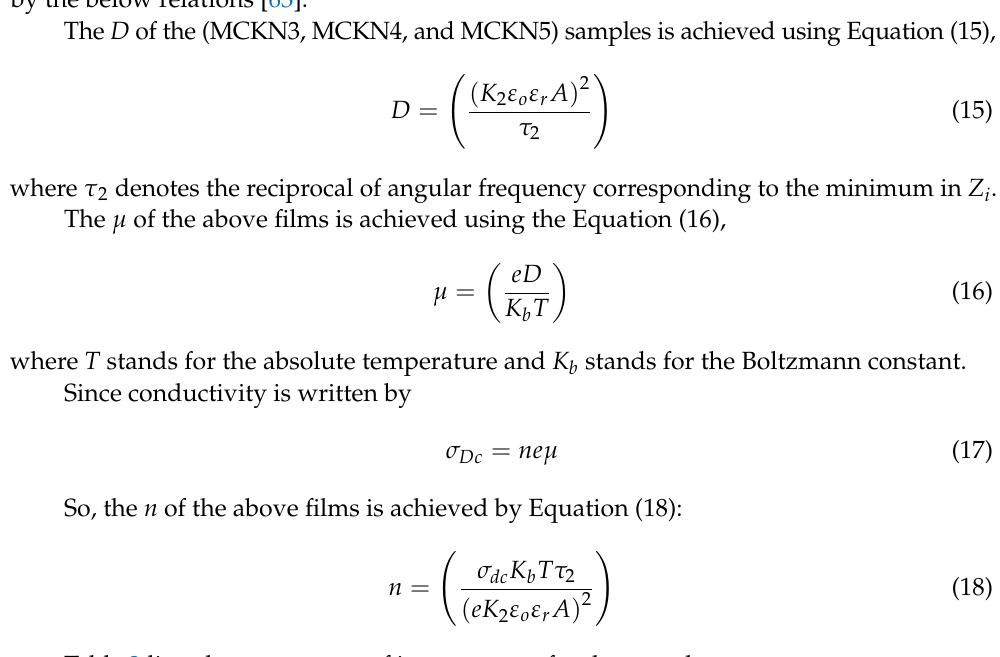
Table 2 lists the parameters of ion transport for the samples. Table 2. The values of D , µ , and n at room temperature from EIS measurement.